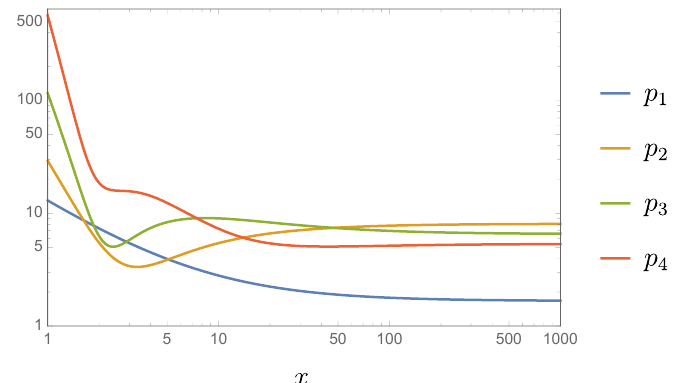
Figure 1 . The coe(cid:14)cients of the perturbative expansion of the MS (cid:12) -function in (cid:21) f = n f a in the Veneziano limit, see eq. (2.2). The plot shows 6 (cid:0) p i (1 =x ) as a function of x in a log-log scale, the o(cid:11)set was chosen so that the functions stay positive in the full range of x . We see that for large x the perturbative expansion appears to be much better behaved than for x (cid:24)